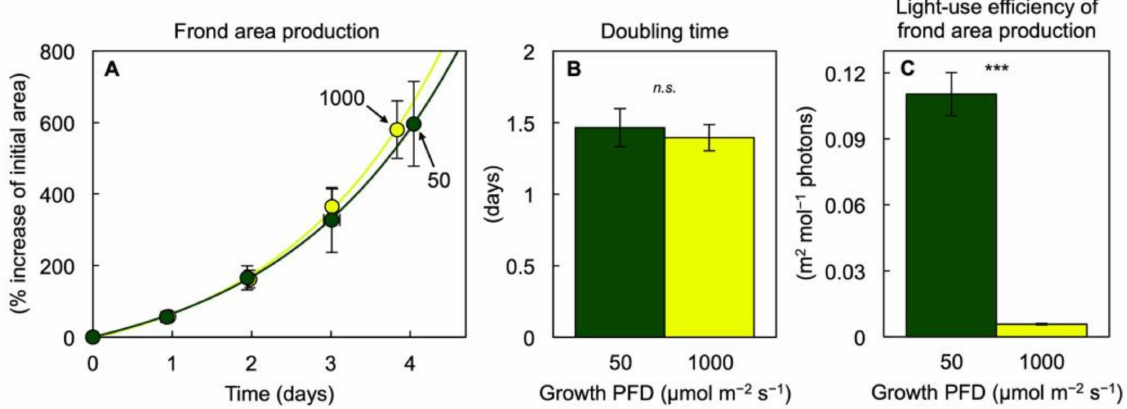
Figure 1. ( A ) Accumulation of frond area (% relative to frond area at the beginning of the experiment) over four days of growth, ( B ) average doubling time in frond area over this four-day period, and ( C ) light-use efficiency of frond area production (total frond area produced relative to incident PFD during the four-day growth period) in Lemna gibba plants under growth PFDs of 50 (green) or 1000 (yellow) µ mol m − 2 s − 1 . Mean values ± standard deviations; n = 7 for 50 µ mol photons m − 2 s − 1 ; n = 3 for 1000 µ mol photons m − 2 s − 1 . A significant difference between the growth PFDs is denoted by asterisks in ( C ); *** = p < 0.001; n.s. = not significantly